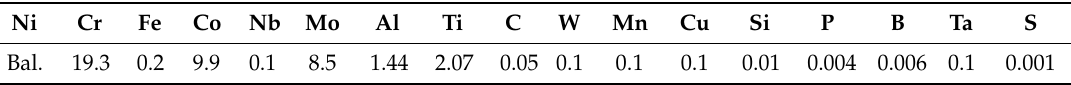
Table 1. Chemical composition of cast Haynes ® 282 ® in wt. % provided by material supplier.